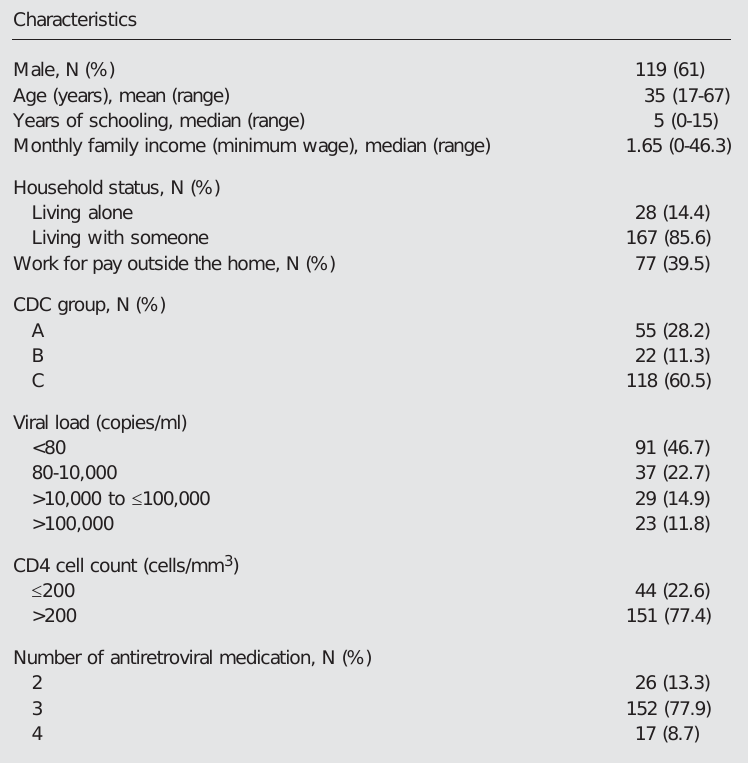
Table 1. Characteristics of the patients (N = 195).